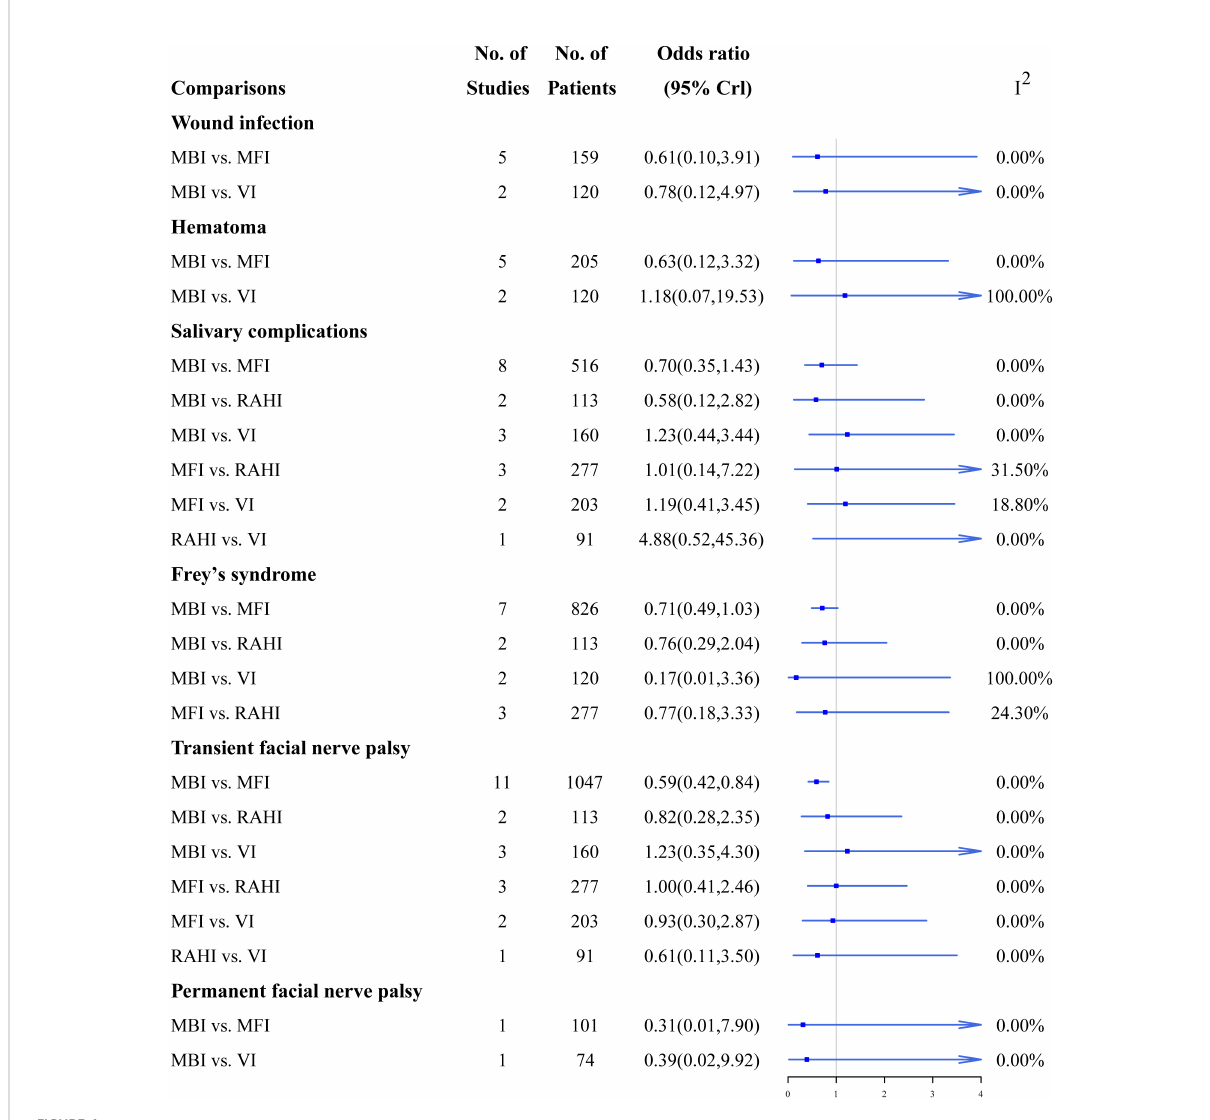
FIGURE 4 A direct comparison forest map of dichotomous